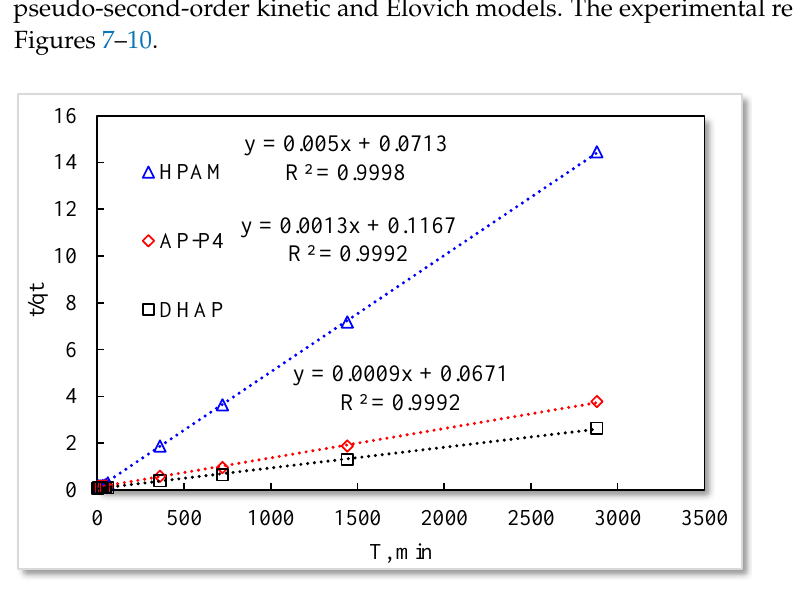
Figure 7. Pseudo-second-order kinetic model.